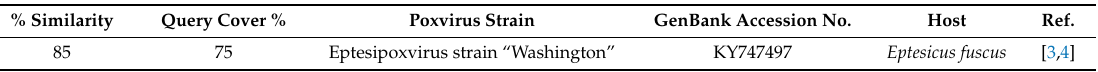
Table 2. Highest nucleotide sequence identities for the nearly complete genome of